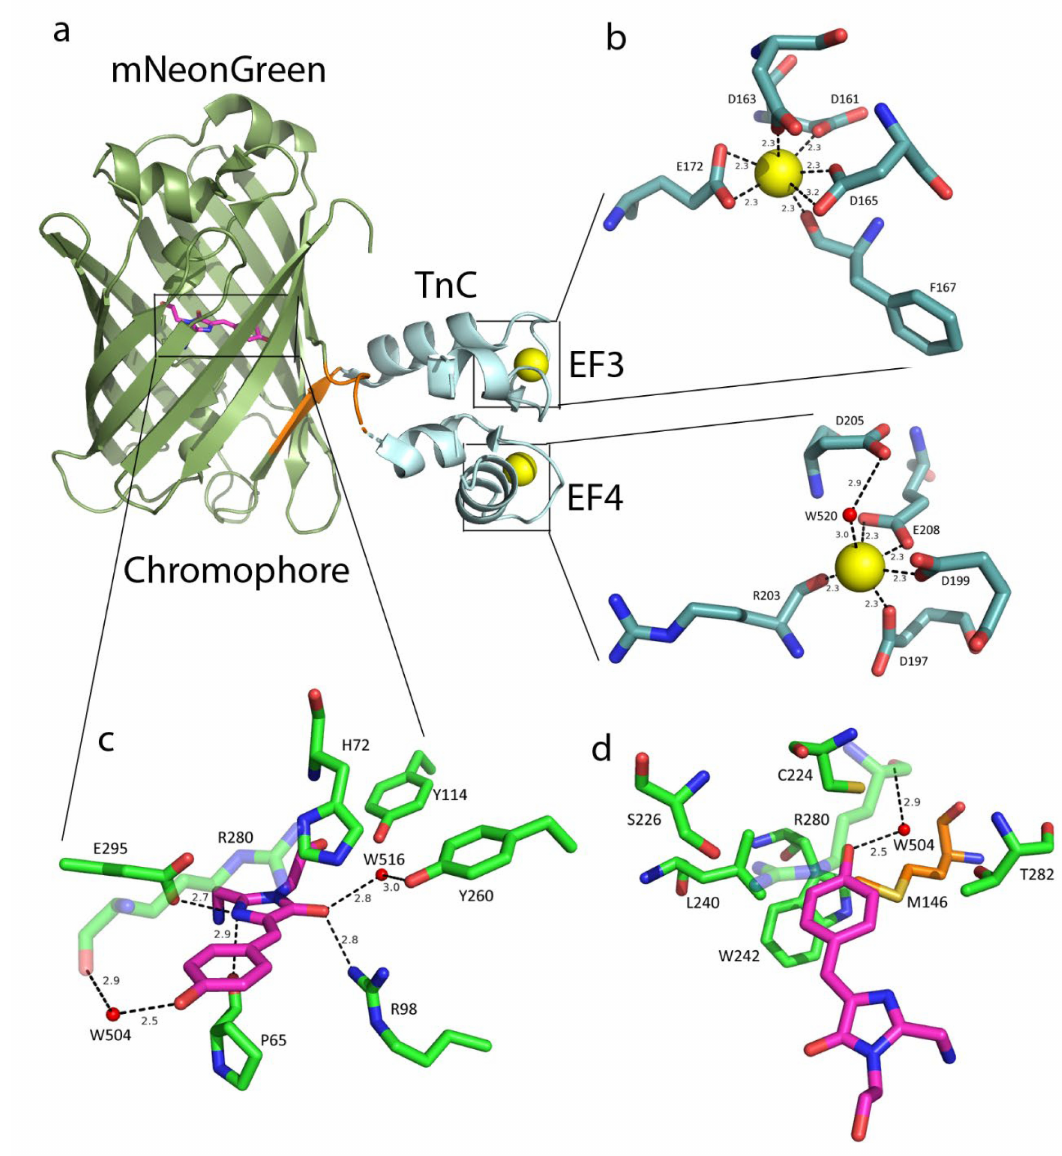
Figure 1. Crystal structure of the NTnC indicator in the Ca 2+ -bound state (PDB 5mwc). ( a ) The overall structure of NTnC. TnC, troponin C. Ca 2+ -binding motifs 3 and 4 (EF3 and EF4). ( b ) Ca 2+ ions and water molecules are represented as yellow and red spheres, respectively; the numbering corresponds to the NTnC sequence. Hydrogen bonds are shown as dashed lines with corresponding distances. ( c , d ) Chromophore (magenta) with its surrounding environment (green amino acids). Panel ( d ) is rotated by 90 ◦ compared to Panel ( c ). Residues around the phenolic group are depicted. M146 is shown in